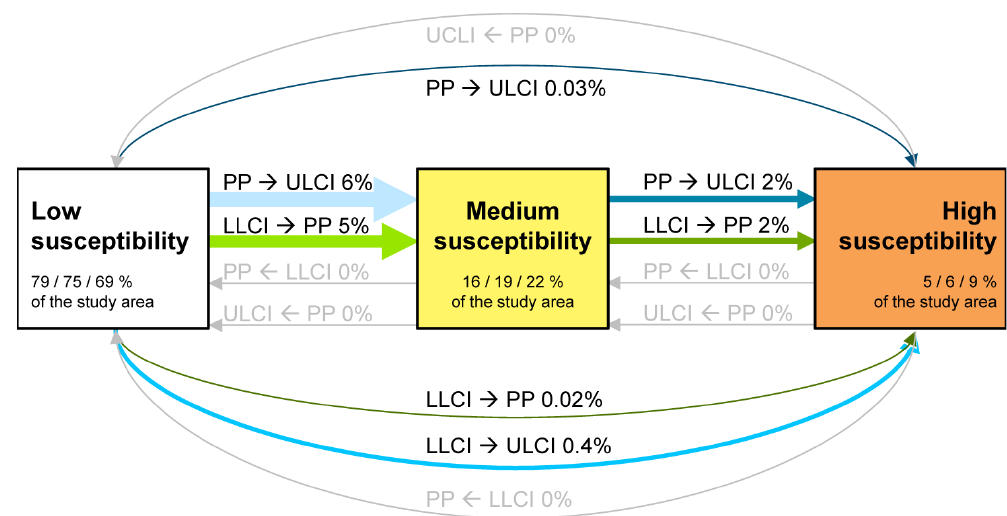
Fig. 7. Susceptibility class uncertainty expressed by types of overlaps between susceptibility maps at the lower confidence limit (LLCI) or the upper confidence limit (ULCI) at the 95% confidence level relative to the class in the predicted probability map (PP). With the susceptibility class the percentage of area in the maps of LLCI, PP and ULCI is given in the box. The arrow thickness is relative to the percentage of affected area. Possible types of overlaps, which did not occur in the study area, are indicated with grey arrows. Next to the type of overlap the percentage of affected area related to the study area is given. In 85% of the study area, the 95% confidence limits fall within the same susceptibility class (not indicated here).